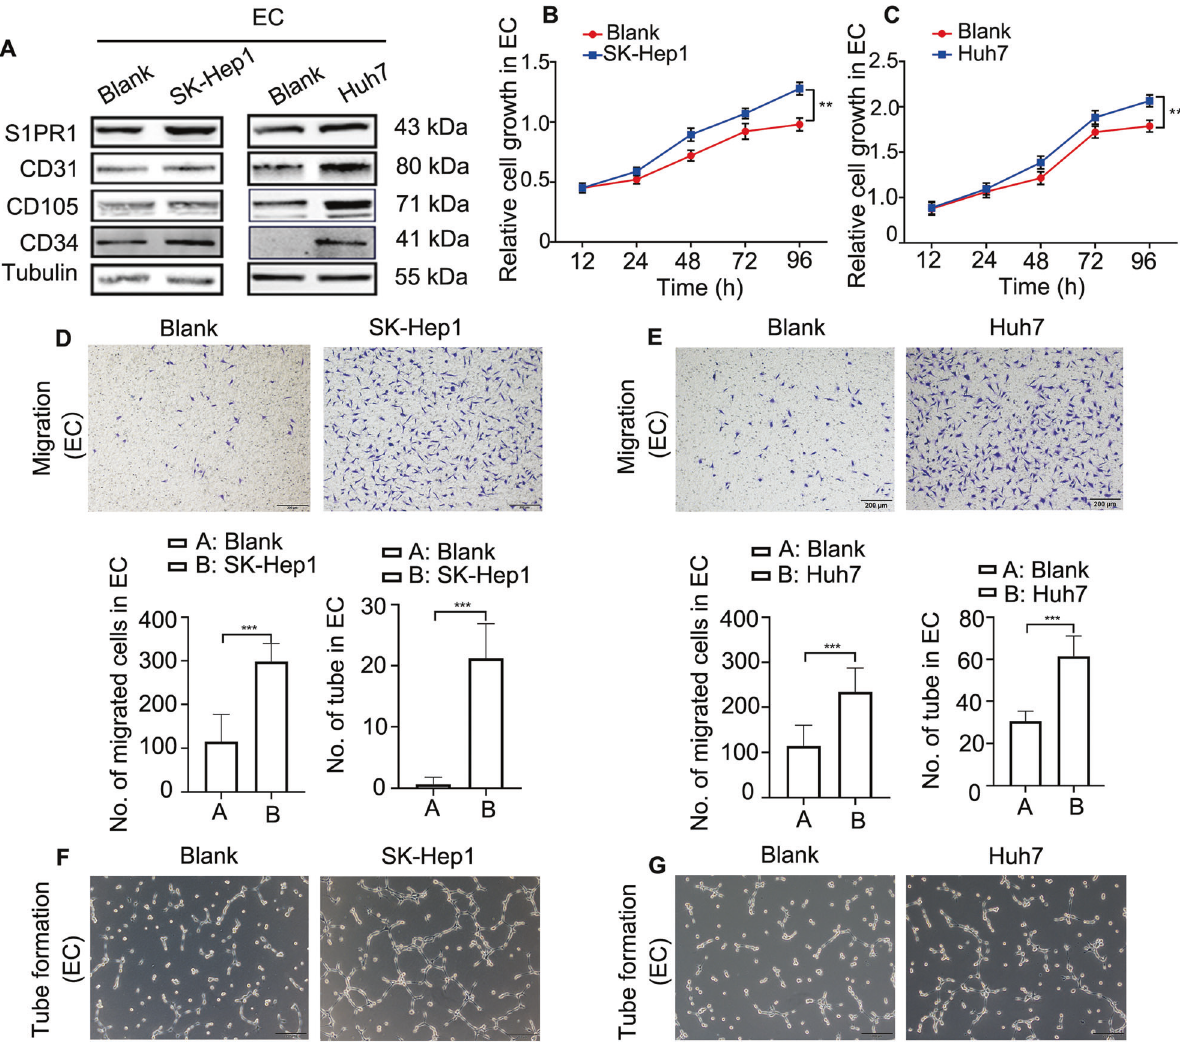
Fig. 2 The functions of HAECs induced by conditioned media from HCC cells (SK-Hep1 and Huh7) are enhanced. A The markers of ECs CD31/CD34/CD105 and S1PR1 in HAECs induced by conditioned media from SK-Hep1 and Huh7 cells were assessed by WB. B , C CCK-8 was used to detect the proliferative ability of HAECs induced by conditioned media from SK-Hep1 cells ( B ) and Huh7 cells ( C ). D , E Migration of HAECs treated with conditioned media from SK-Hep1 cells ( D ) and Huh7 cells ( E ). Scale bar: 200 μ m. F , G Tube formation of HAECs treated with conditioned media from SK-Hep1 cells ( F ) and Huh7 cells ( G ), indicating angiogenic ability. Scale bar: 200 μ